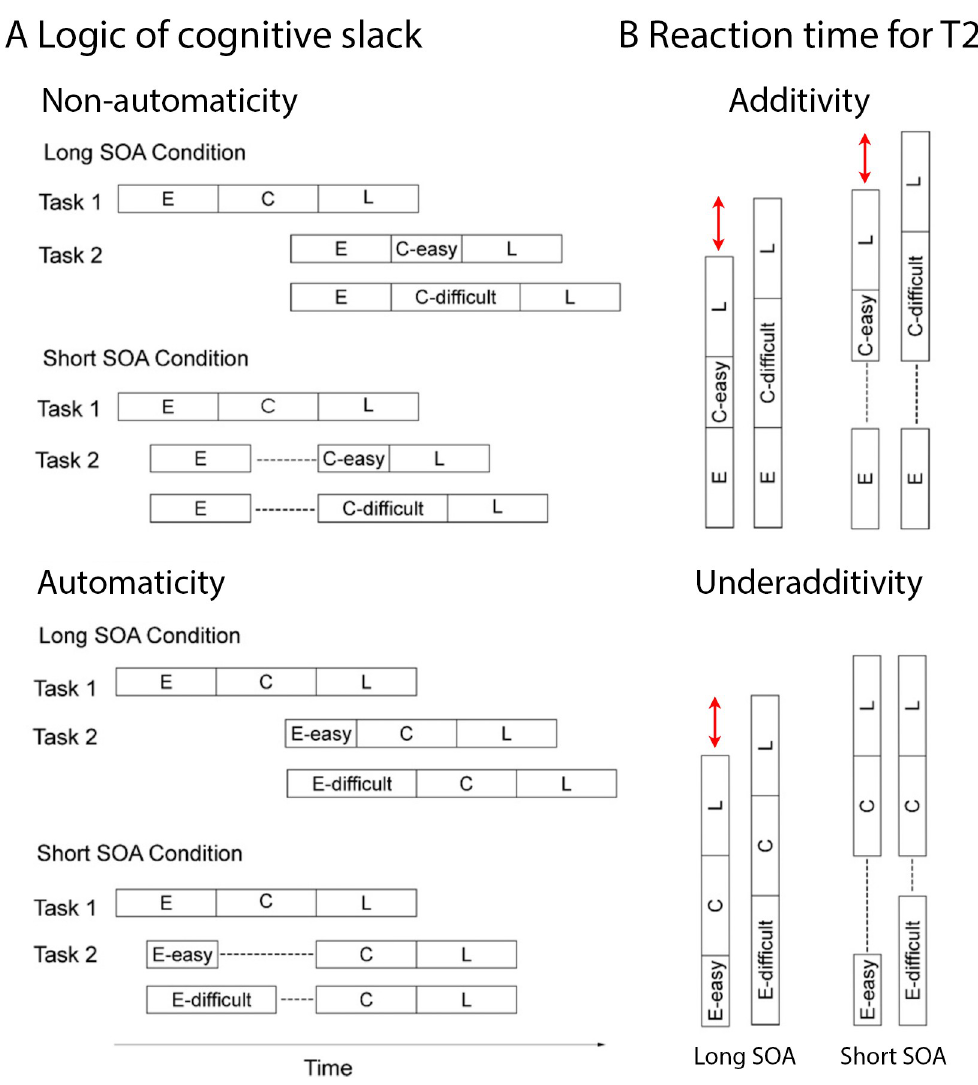
Fig 1. Logic of cognitive slack and predicted reaction times. A. Schematic depiction of the logic of cognitive slack. Early (E), central (C), and late (L) processes of Task 1 (T1) and Task 2 (T2) of a PRP paradigm, for long and short stimulus onset asynchrony (SOA) conditions. Top. Difficulty manipulation of a central T2 process, which is non-automatic, i.e. which needs the central bottleneck to proceed, with the difficulty effect predicted not to differ between SOA conditions. Bottom. Difficulty manipulation of an early T2 process, which is automatic, i.e. located before the central bottleneck, with the difficulty effect predicted to be absorbed into slack (---) in the short SOA condition. B. Predicted reaction times (RT) for T2 (extracted from panel A and synchronized to the start of T2), for the long SOA condition on the left and the short SOA condition on the right. The key prediction is highlighted in red. Specifically, the difficulty manipulation of a non-automatic process (top) is predicted to have the same effect on RT in the short and long SOA condition. On the other hand, the difficulty manipulation of an automatic process (bottom) is predicted to have an effect in the long SOA condition, but this effect should be eliminated (or diminished) in the short SOA